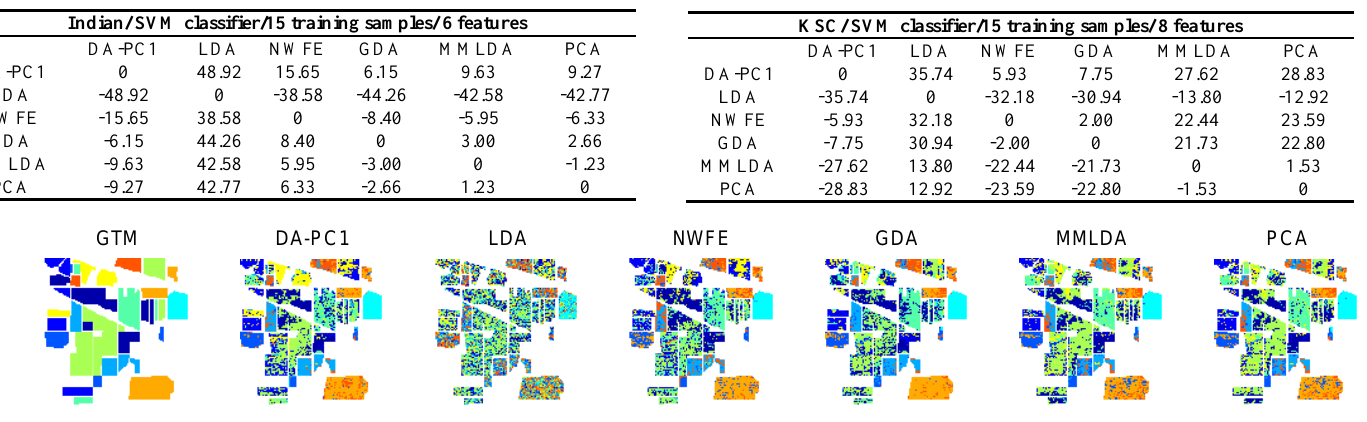
Table 3. The values of parameter 𝒁 obtained by McNemar test.